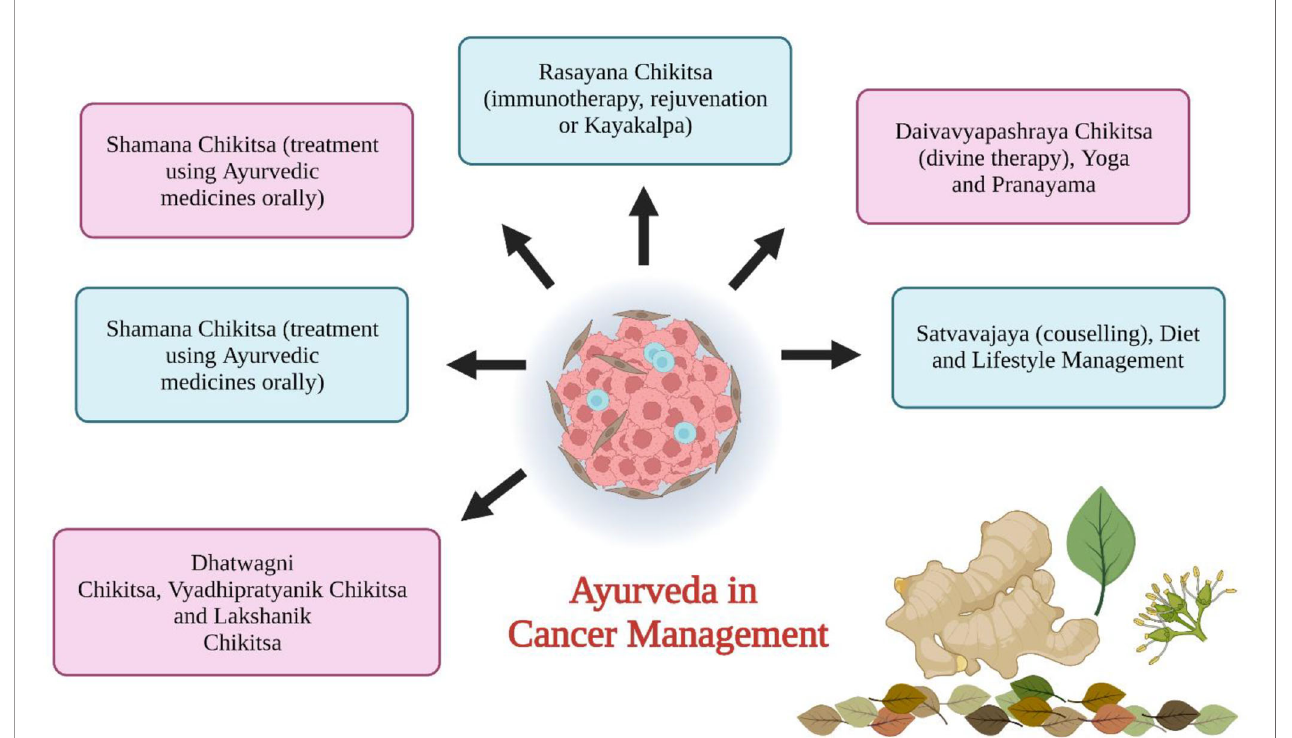
FIGURE 1 | Different cancer management procedures in